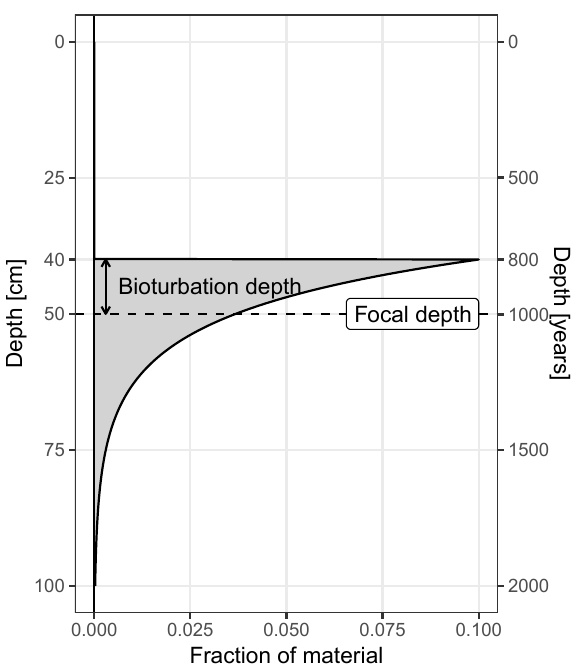
Figure 1. The origin of material archived at a focal core depth of 50cm. In this example the bioturbation depth is 10cm, and the sed- iment accumulation rate is 50cmkyr − 1